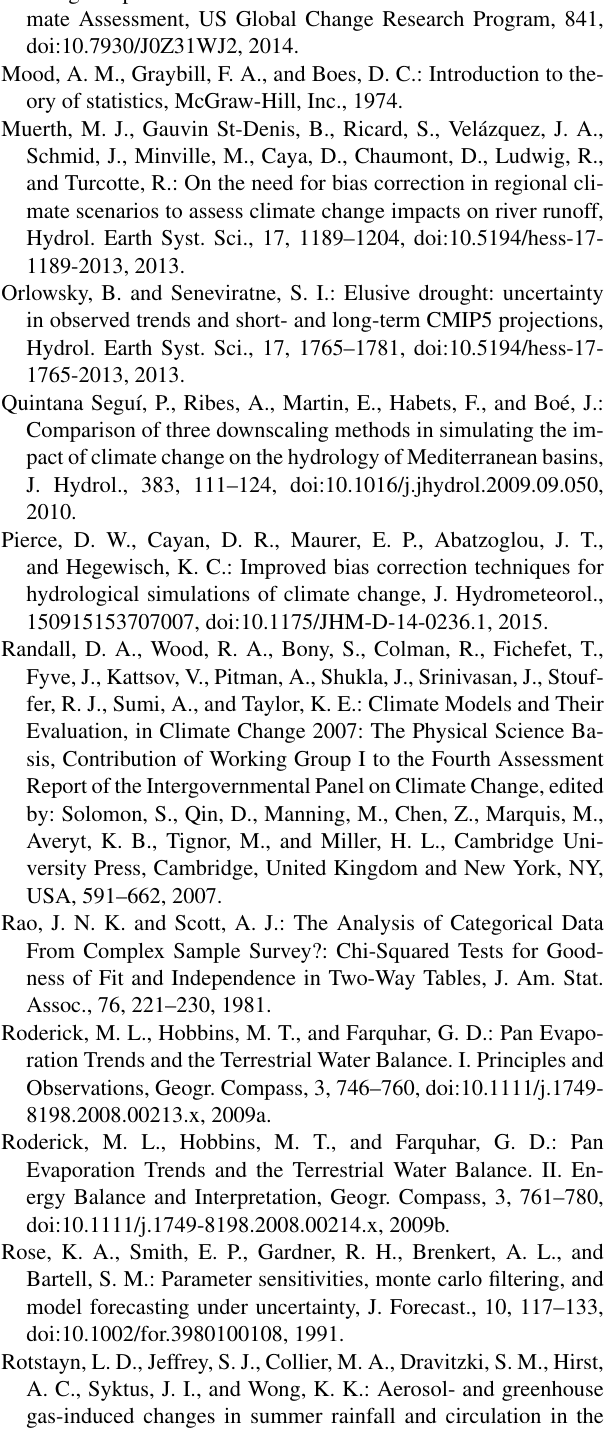
Tabari, H., Grismer, M. E., and Trajkovic, S.: Comparative